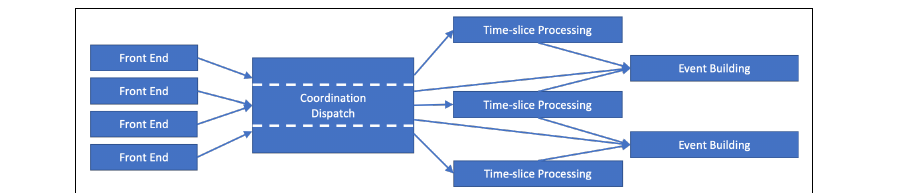
Figure 3. A block diagram of the data processing stages anticipated in Phase III of Project 8. Starting from the left, the front-end receivers will host a single FPGA and operate as many ADCs as the FPGA’s capacity allows. The number of front-end systems will be driven by the final channel count and the number of channels per board. Next, a data coordination and dispatch stage will collect streams of data from each independent channel and output blocks of data which include all channels for a limited time interval, with potential for scalability based on limitations of network bandwidth. The processing of data blocks will include both computing a complete set of phased combination of channels, and triggering a signal search on the output of each combination. Finally, after an event has been identified, only those time-intervals and phased combinations with relevant signals will be written to